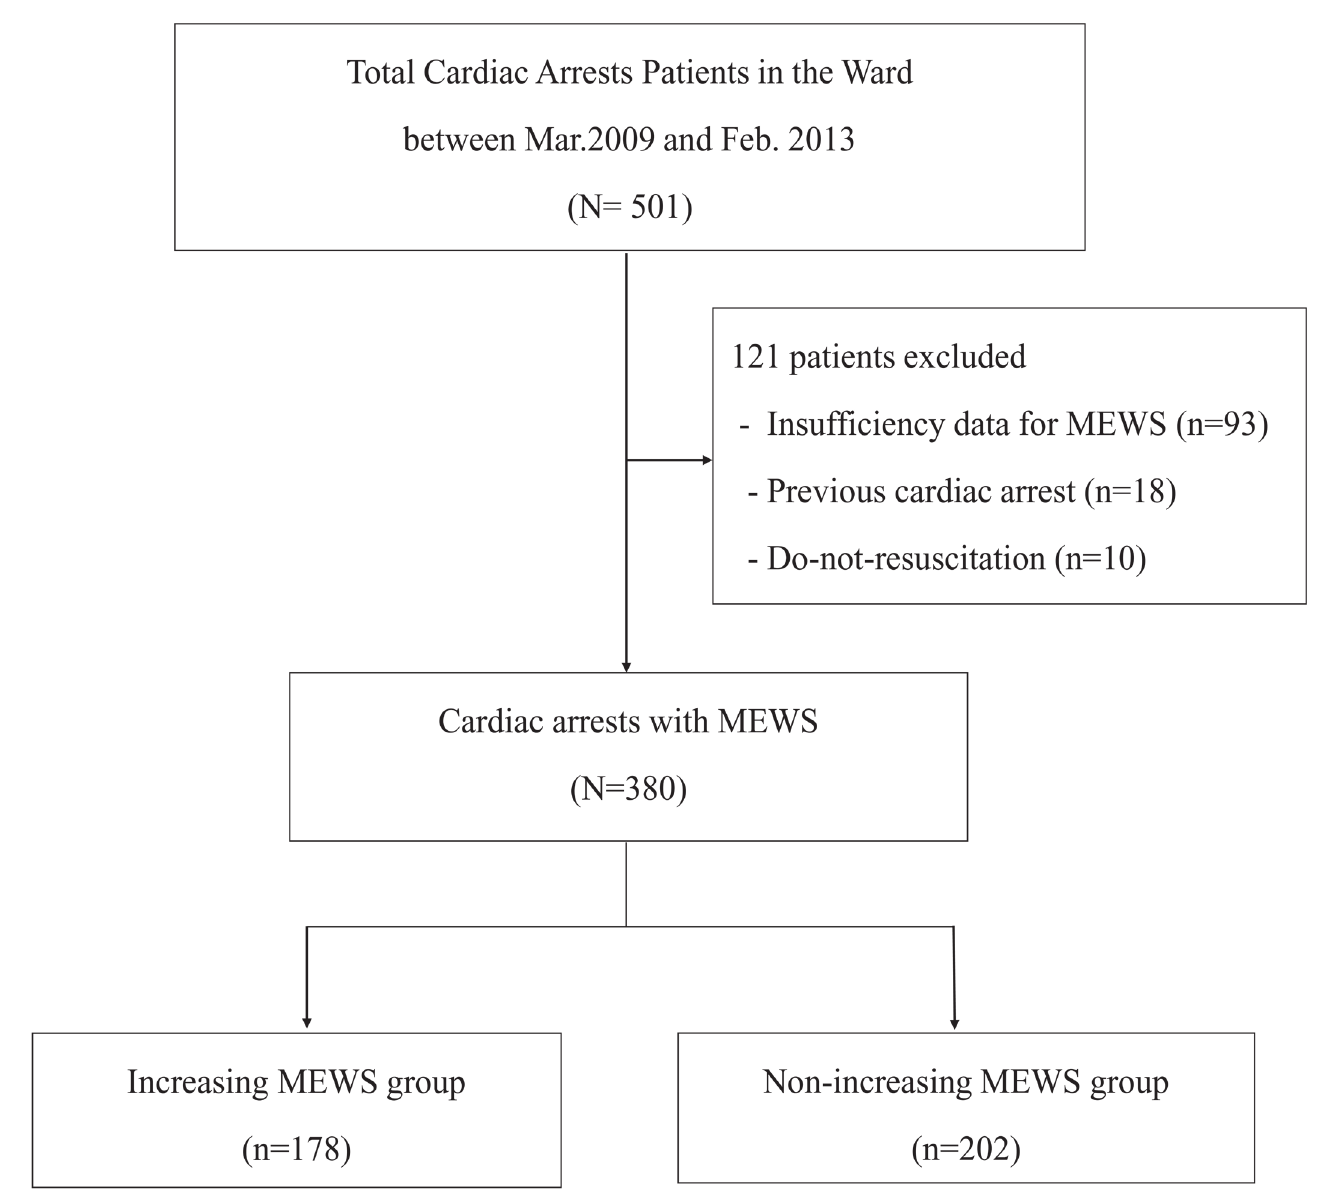
Fig 1. Flow chart for the selection of patient. MEWS = Modified early warning